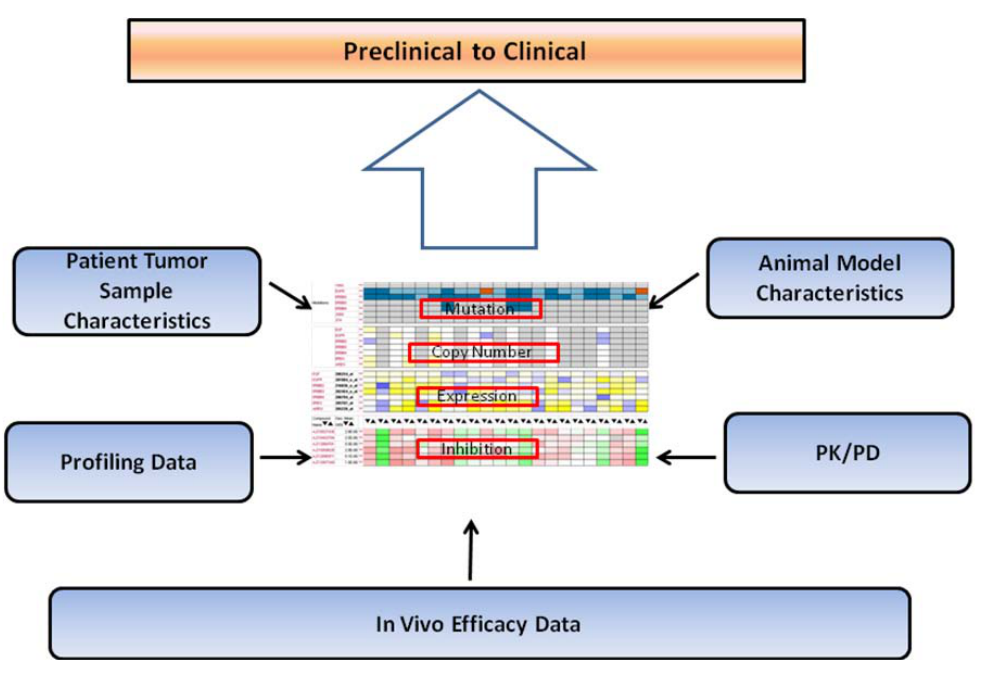
Figure 3: In vivo data clustering for hypothesis